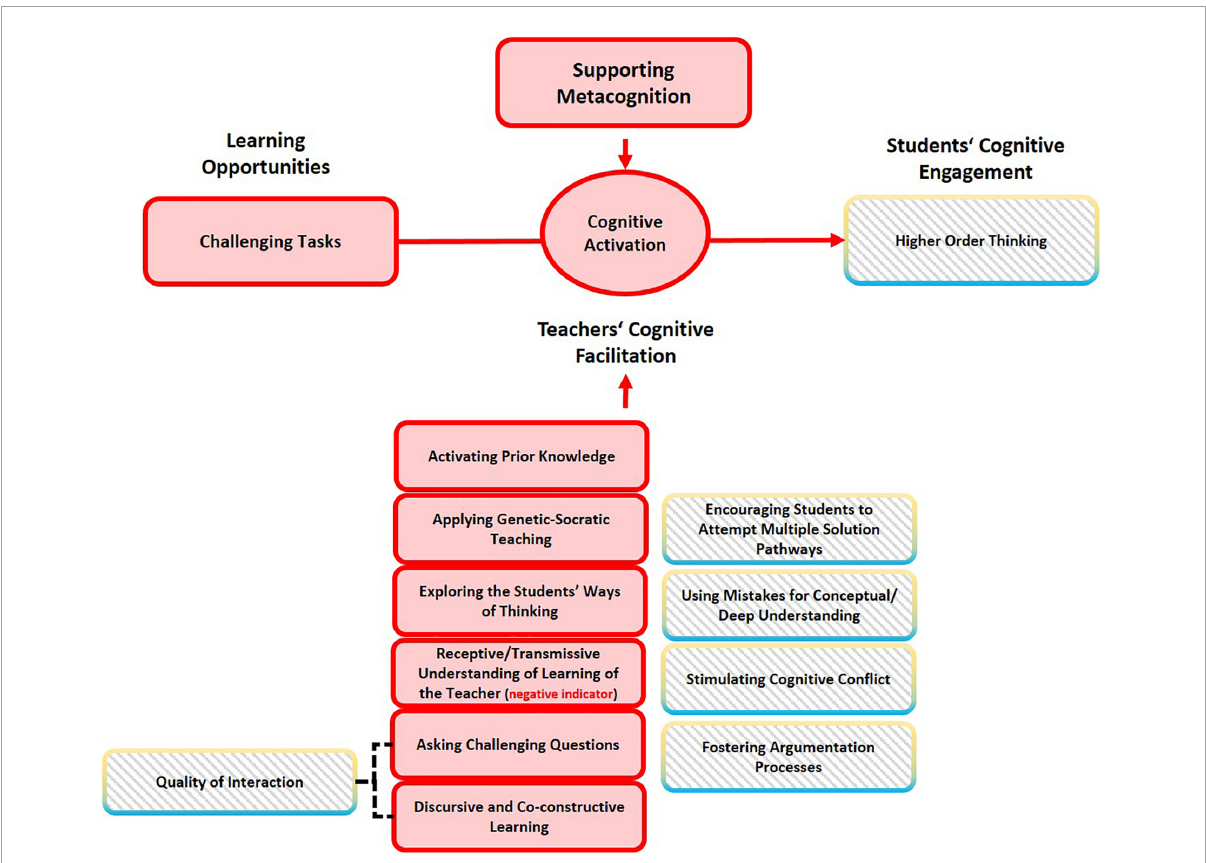
FIGURE5 Suggested adjustments on the measurement framework of Cognitive Activation according to the comparison between conceptual indicators and empirical measurement